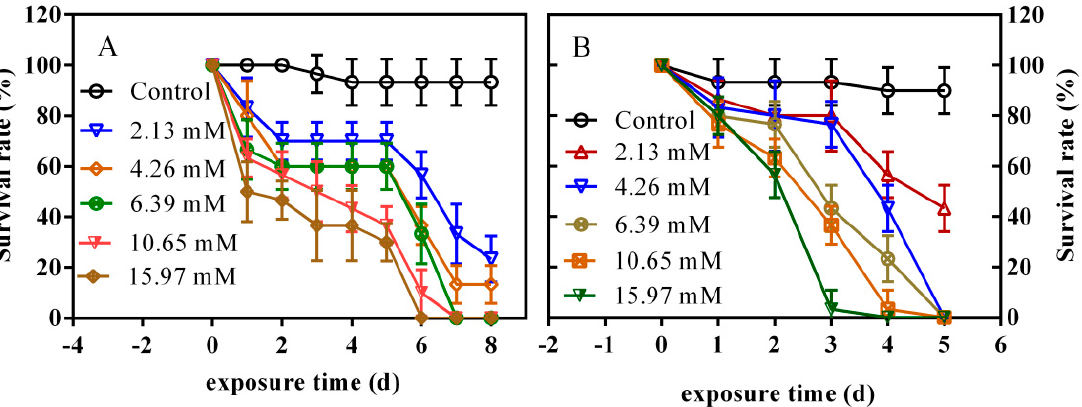
Figure 6. Effect of PFLX exposure on the survival rate of the zebrafish embryo ( A ) and larvae ( B ). Lethal Concentration 50 (LC 50 ) is the concentration of the agent that killed 50% of